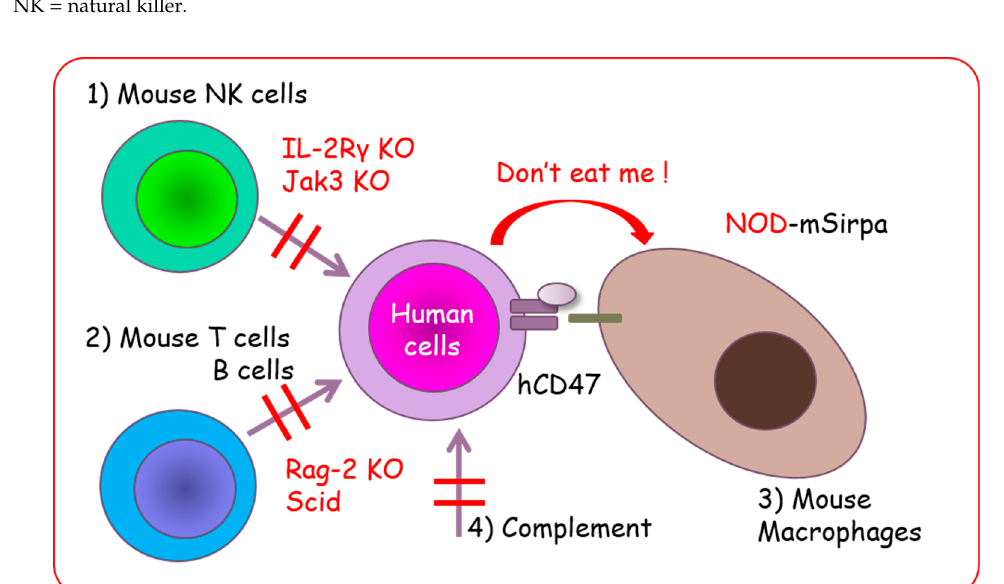
Figure 1. NOG, NSG, and NOJ mice with multiple immune deficiencies are excellent recipients for human cell engraftment. (1) Loss of NK cells; (2) loss of acquired immunity by T and B lymphocyte deficiency; (3) “Don’t eat me” signal by NOD ‐ signal regulatory protein alpha (Sirp α ); and (4) loss of complement.